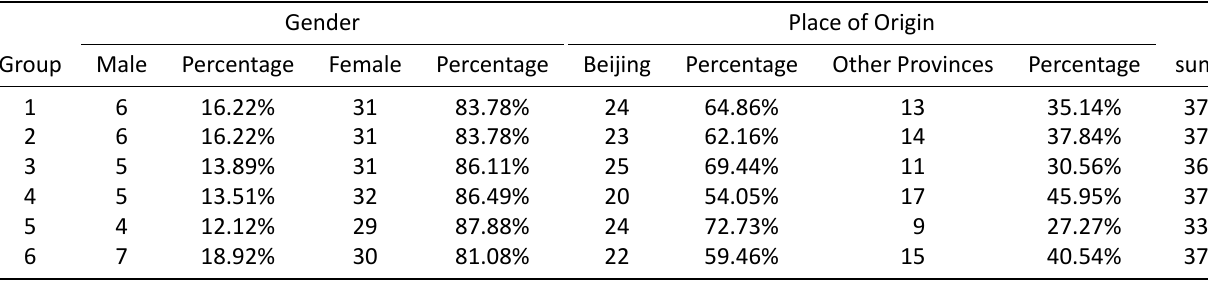
Table 1. Gender and place of origin of each group.